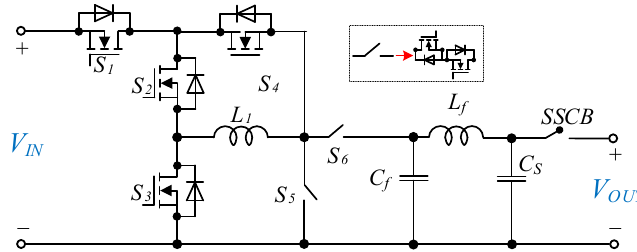
Figure 3. FI-based universal DC-DC/AC interface converter [28].